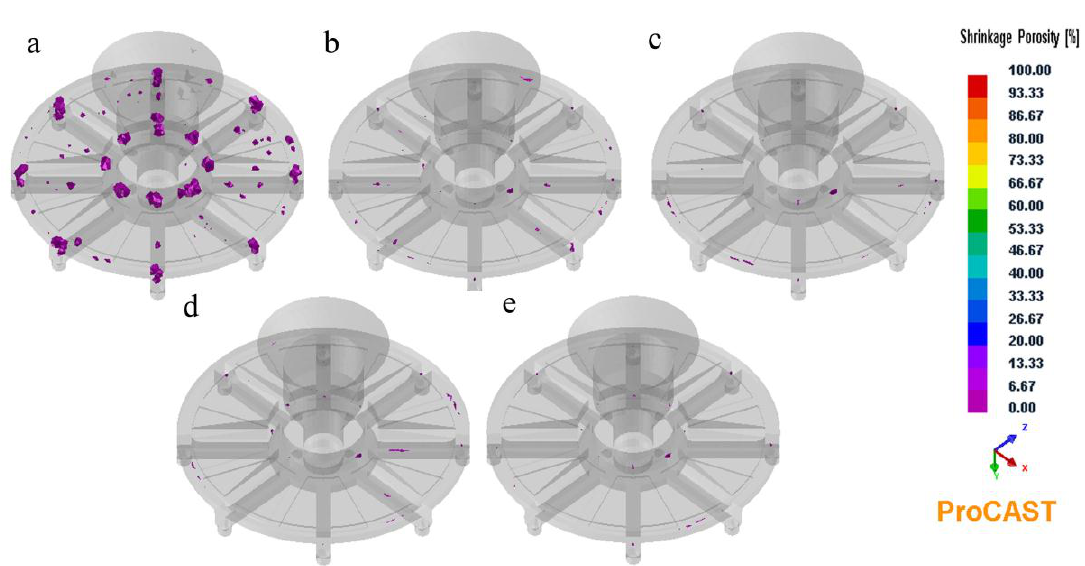
Figure 10. The predicted shrinkage porosity of full-size castings, ( a ) mold temperature of 600 °C and gravity casting (short for 600 °C, 0 rpm); ( b ) 200 °C, 200 rpm; ( c ) 400 °C, 200 rpm; ( d ) 600 °C, 200 rpm; ( e ) 600 °C, 400